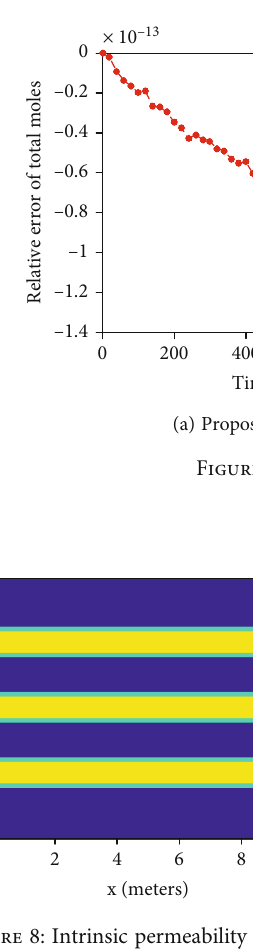
Figure 8: Intrinsic permeability in example 2.